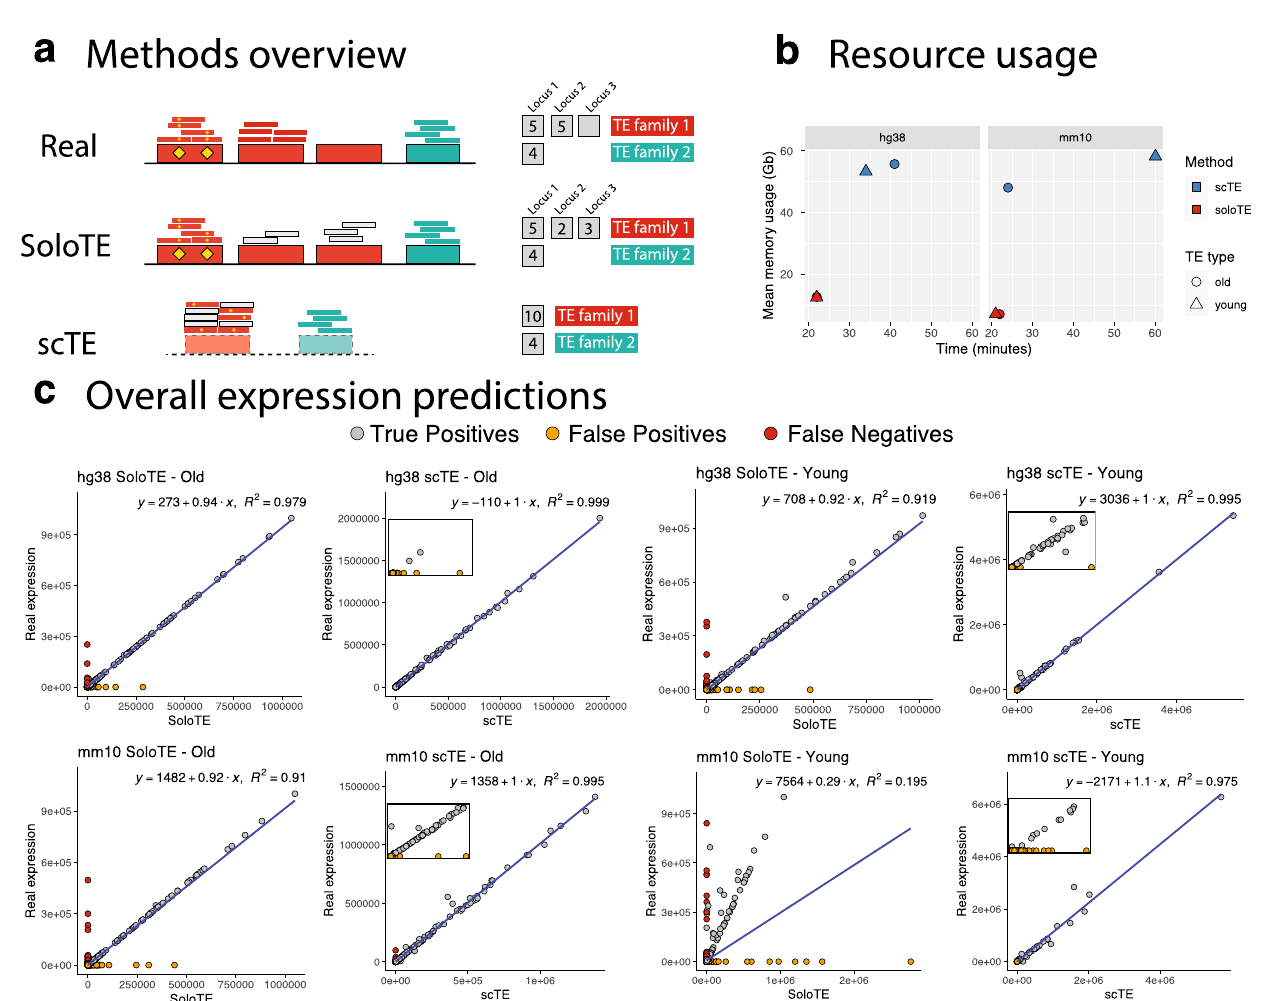
Fig. 1 General comparison between SoloTE and scTE. a Overview of the read assignment per TE of each method. Four TEs are depicted, with three of them belonging to “ family 1 ” (in red) and the remaining one to “ family 2 ” (in cyan). Yellow diamonds indicate sequence variations speci fi c to a TE. The smaller rectangles above each TE correspond to reads assigned to that speci fi c location, with small gray rectangles corresponding to multi-mapped reads. The counts to the right indicate how each method calculates TE expression. “ Real ” : the expected situation in which 2 TEs from family 1 are expressed, and 1 TE from family 2 is expressed. “ SoloTE ” : reads are assigned to each locus, with multi-mapped reads assigned to a random location. “ scTE ” : dashed rectangles indicate that reads are assigned to TE metagenes, and summarized by families. b Memory usage versus time plots of SoloTE and scTE using the datasets simulated in this work: left, simulated data from the human genome hg38 version; right, simulated data from the mouse genome mm10 version. Color indicates the method (scTE in blue, SoloTE in red), and the shape indicates the TE type (circle for Old TEs, and triangle for Young TEs). c Overall expression estimates (without cell demultiplexing) for each simulated dataset. First row corresponds to the comparisons using the hg38 datasets, and the second row to the comparisons using the mm10 datasets. In each plot, the x axis corresponds to the method used to estimate expression (SoloTE or scTE), and the y axis to the real TE expression. Points are colored according to whether they match an expressed TE (gray, “ True Positive ” ), TE mistakenly reported as expressed (orange, “ False Positive ” ), TE expressed but not detected by the method (red, “ False Negative ” ). Inset plots were added to the scTE main plots to show the spread of false positive